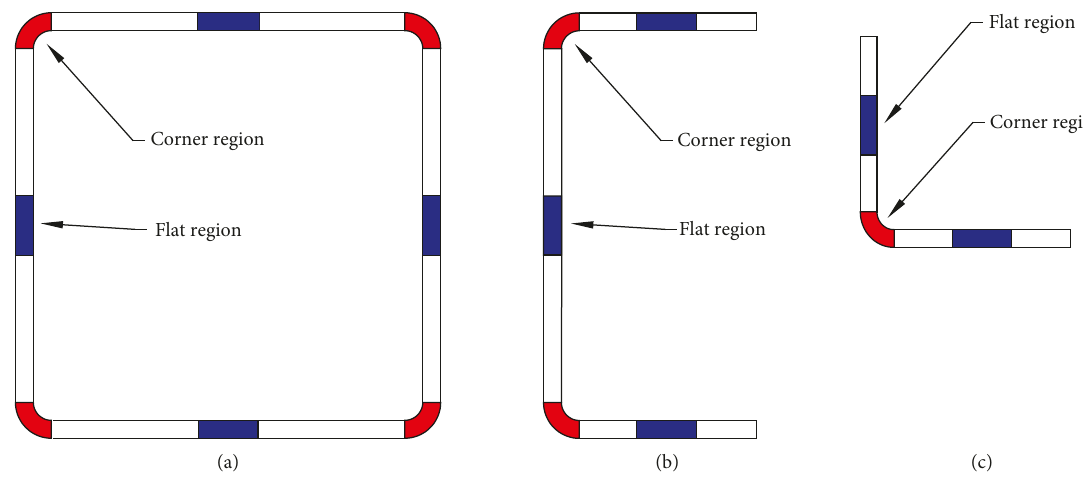
Figure 1: Cold-formed sections: (a) square hollow section; (b) steel channel section; (c) angle